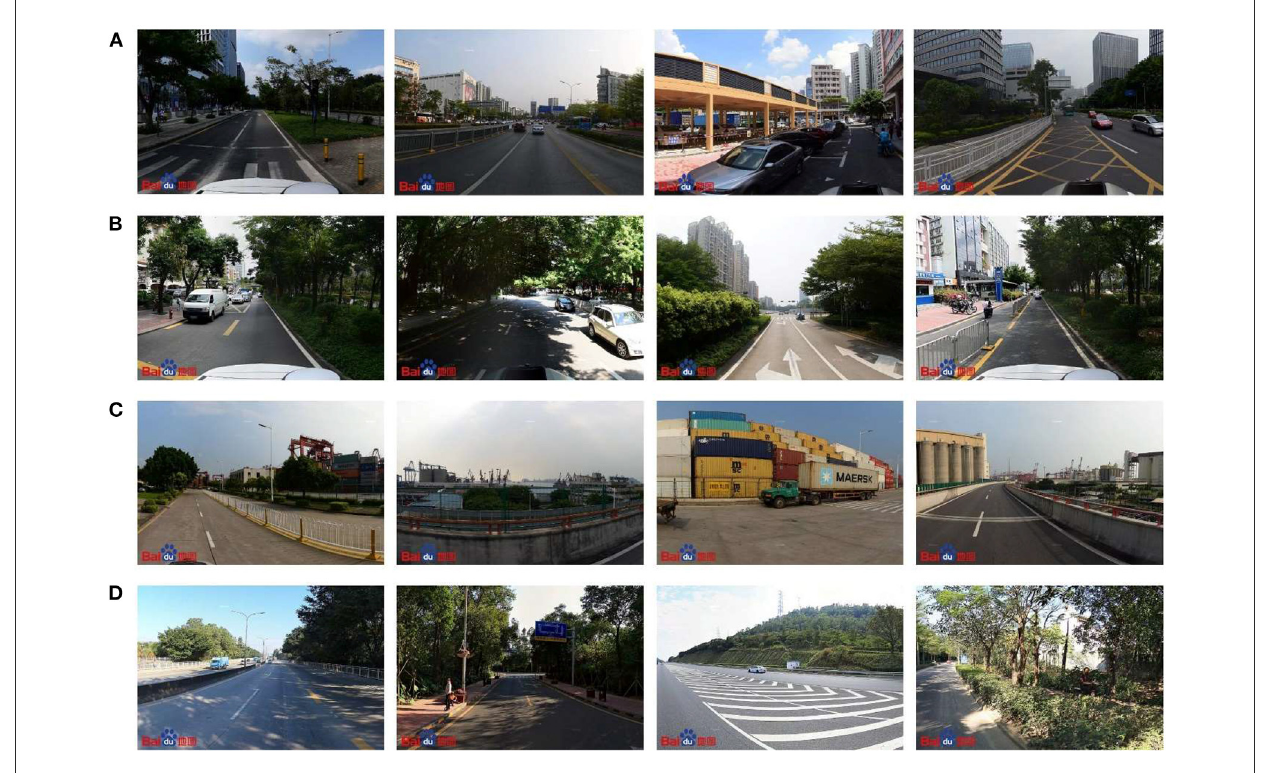
FIGURE9 (A–D) Example map of a representative area street